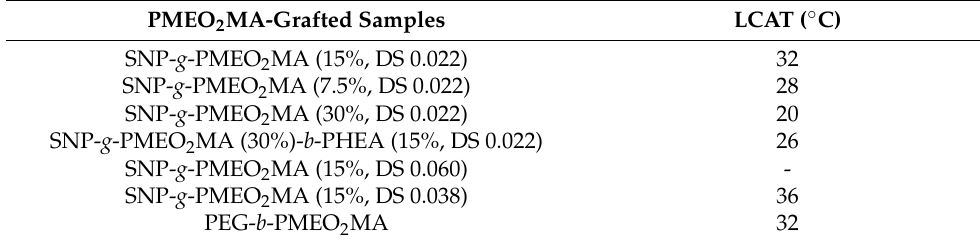
Table 2. LCAT values obtained from the transmittance curves in Figure 4. PMEO 2 MA-Grafted